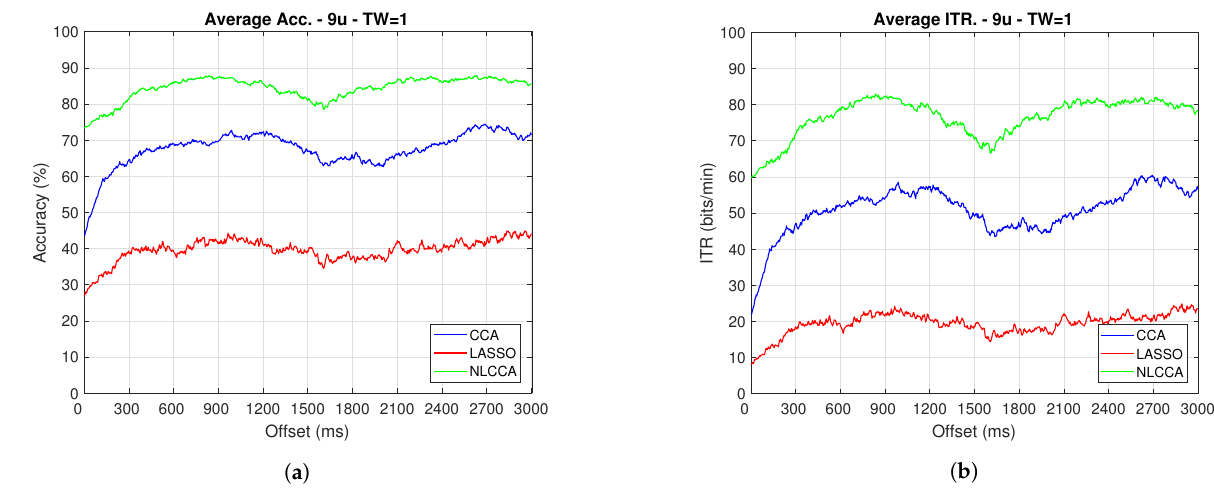
Figure 10. One-second sliding window for ( a ) Accuracy and ( b ) ITR removing User 3. When comparing this behavior to previous studies, it is important to highlight the need for achieving a steady-state in order to obtain the best performance in each approach. However, the study also revealed that LASSO and NLCCA still offer some resistance to the transient response, while CCA does not. Although both ITR results evidence no significant change, NLCCA is much more suitable when the shifting immediately after the flickering exposure is ignored.